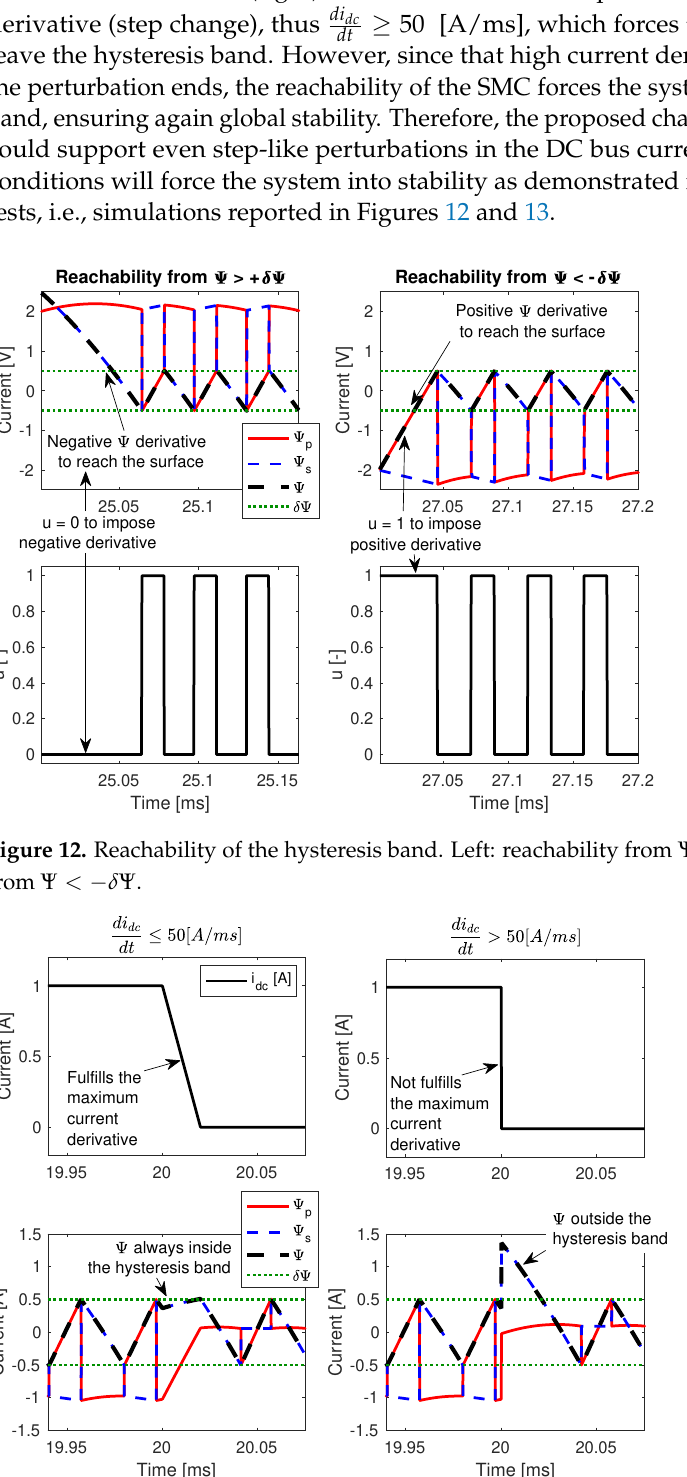
Figure 13. Stability on low-frequency and high-frequency current perturbations. Left : low-frequency perturbation; Right : high-frequency